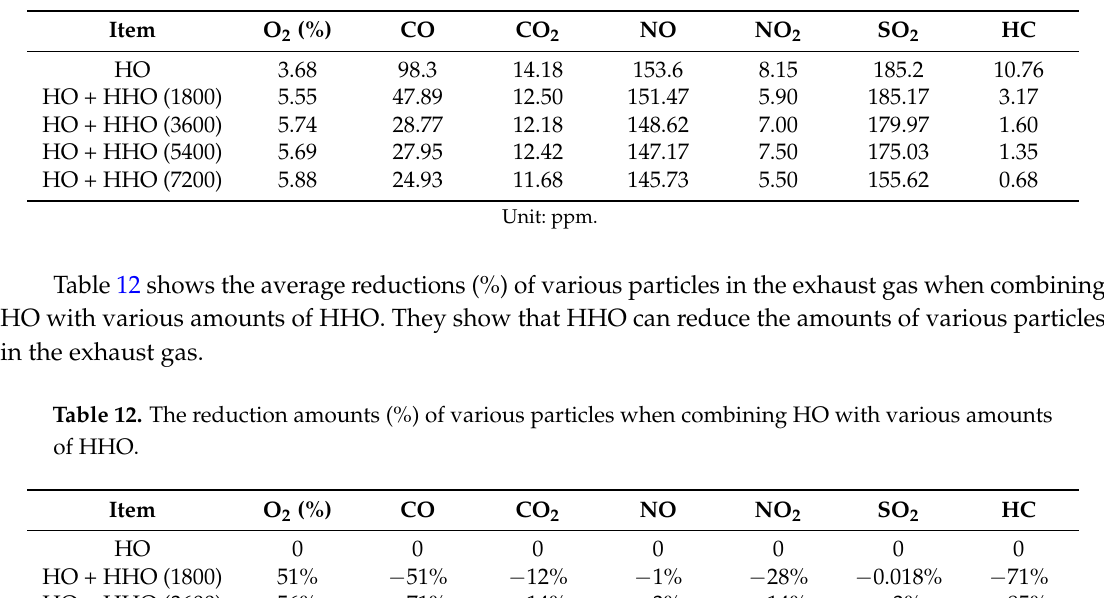
Table 11. Amounts of various particles in the exhaust gas when combining HO with various amounts of HHO.